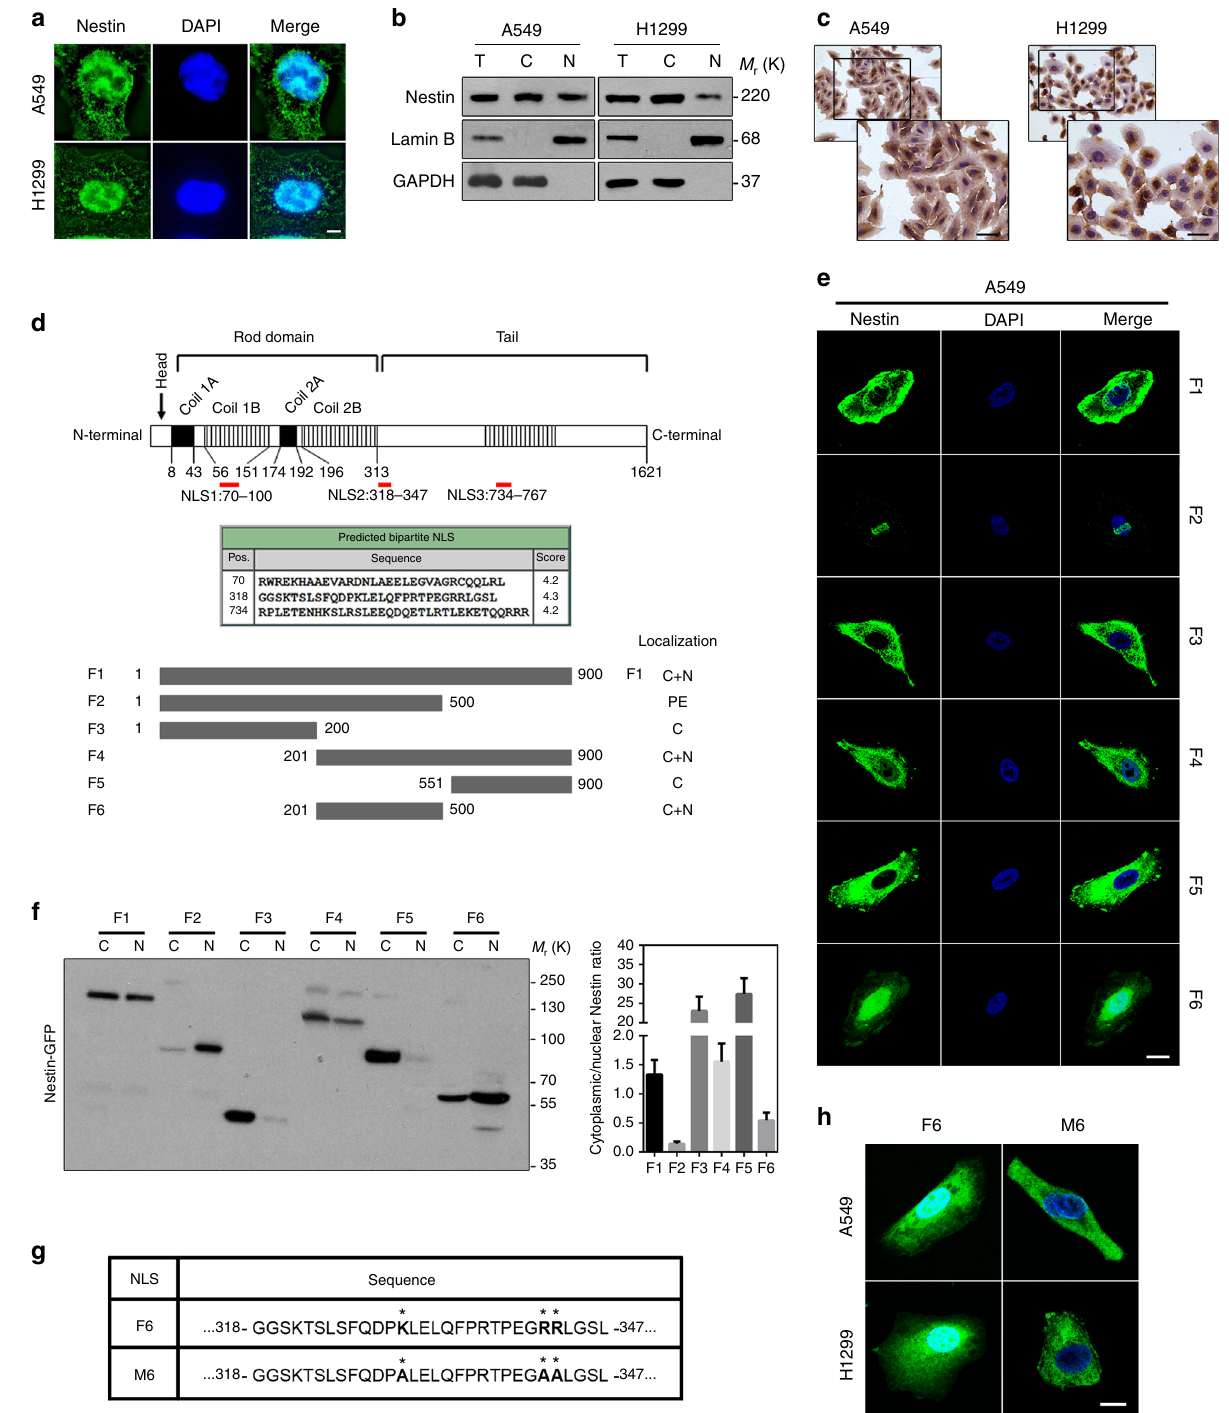
Fig. 3 Nestin contains a nuclear localization signal (NLS). a Confocal images of Nestin immunostaining (green) in A549 and H1299 cells. Scale bars, 5 μ m. b Immunoblotting for subcellular fractions of Nestin in A549 and H1299 cells (T total cell lysates, C cytoplasmic cell lysates, N nuclear cell lysates). c Immunohistochemical staining of Nestin in A549 and H1299 cells. Scale bars, 30 μ m. d Upper: three putative NLSs identi fi ed by bioinformatic analysis. Lower: schematics of the Nestin constructs used for the localization study. Each fusion protein was expressed with a GFP tag (left), and its localization was assessed (right; C, predominantly cytoplasmic; C + N, in both compartments; PE, at the periphery of outer nuclear envelope). e Confocal images of GFP- Nestin fusion protein in A549 cells. Nuclei were marked by DAPI (blue). Scale bars, 20 μ m. f Immunoblotting analysis of GFP-Nestin distribution in A549 cells (left; C cytoplasmic cell lysates, N nuclear cell lysates) and the corresponding cytoplasm/nucleus intensity ratio (CN ratio) of GFP-tagged proteins (right). g , h Schematics of the GFP-tagged Nestin constructs showing the sequences ( g ) and positions ( h ) of a potential NLS and the targeted aa substitutions (asterisk) used to disable it. Scale bars, 10 μ